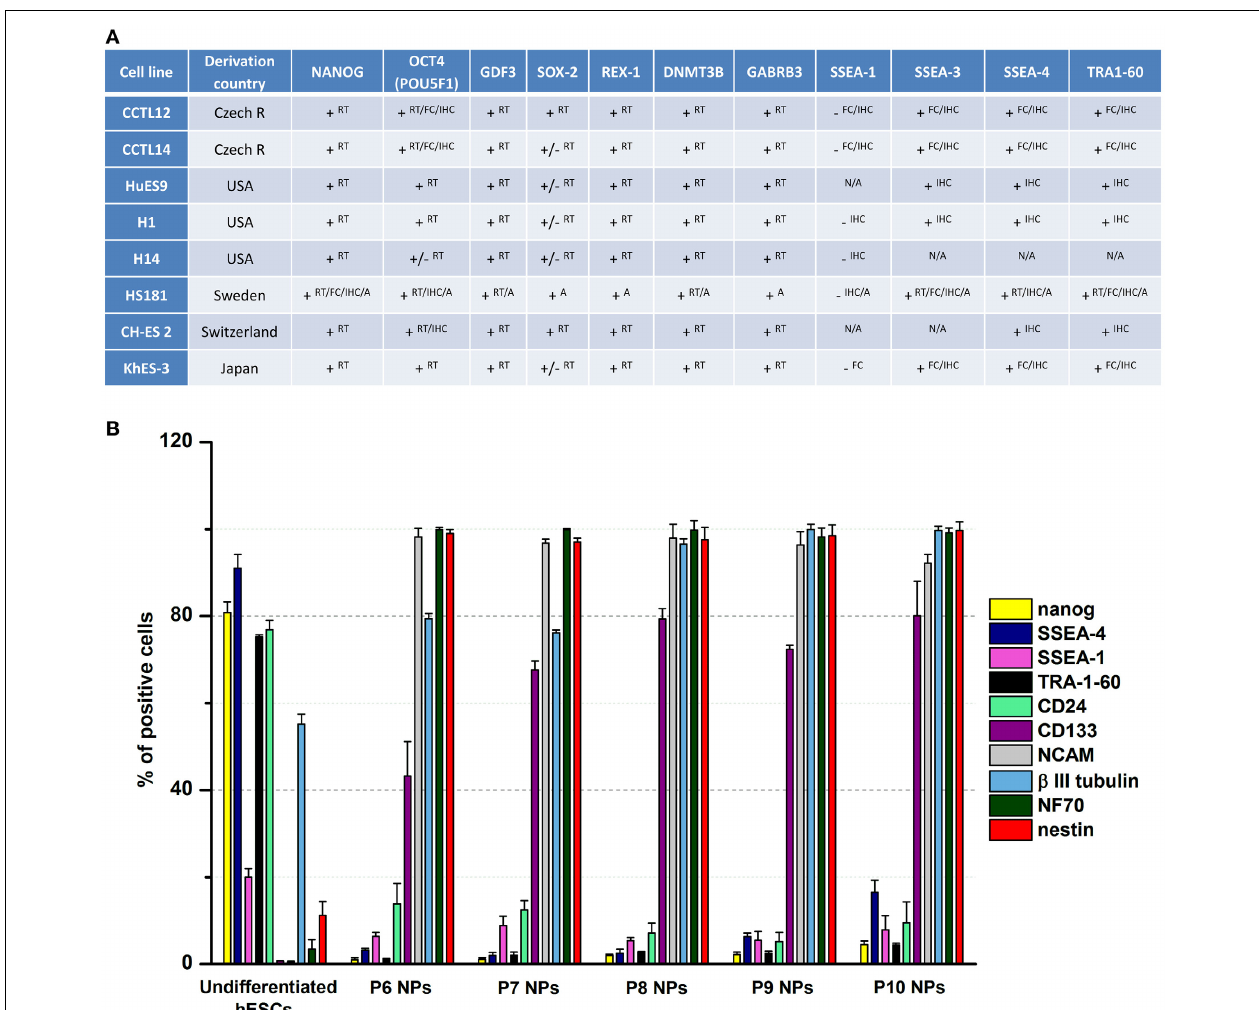
pluripotent and neural markers in undifferentiated hESCs and hESC-derived NPs (P6–P10) during long-term propagation in vitro . The predifferentiation of hESCs led to the downregulation of pluripotent markers (Nanog, SSEA-4, SSEA-1, TRA-1-60, and CD24) and upregulation of neural markers (CD133, NCAM, β -III tubulin, NF70, and nestin). Data presented in Kozubenko et al.